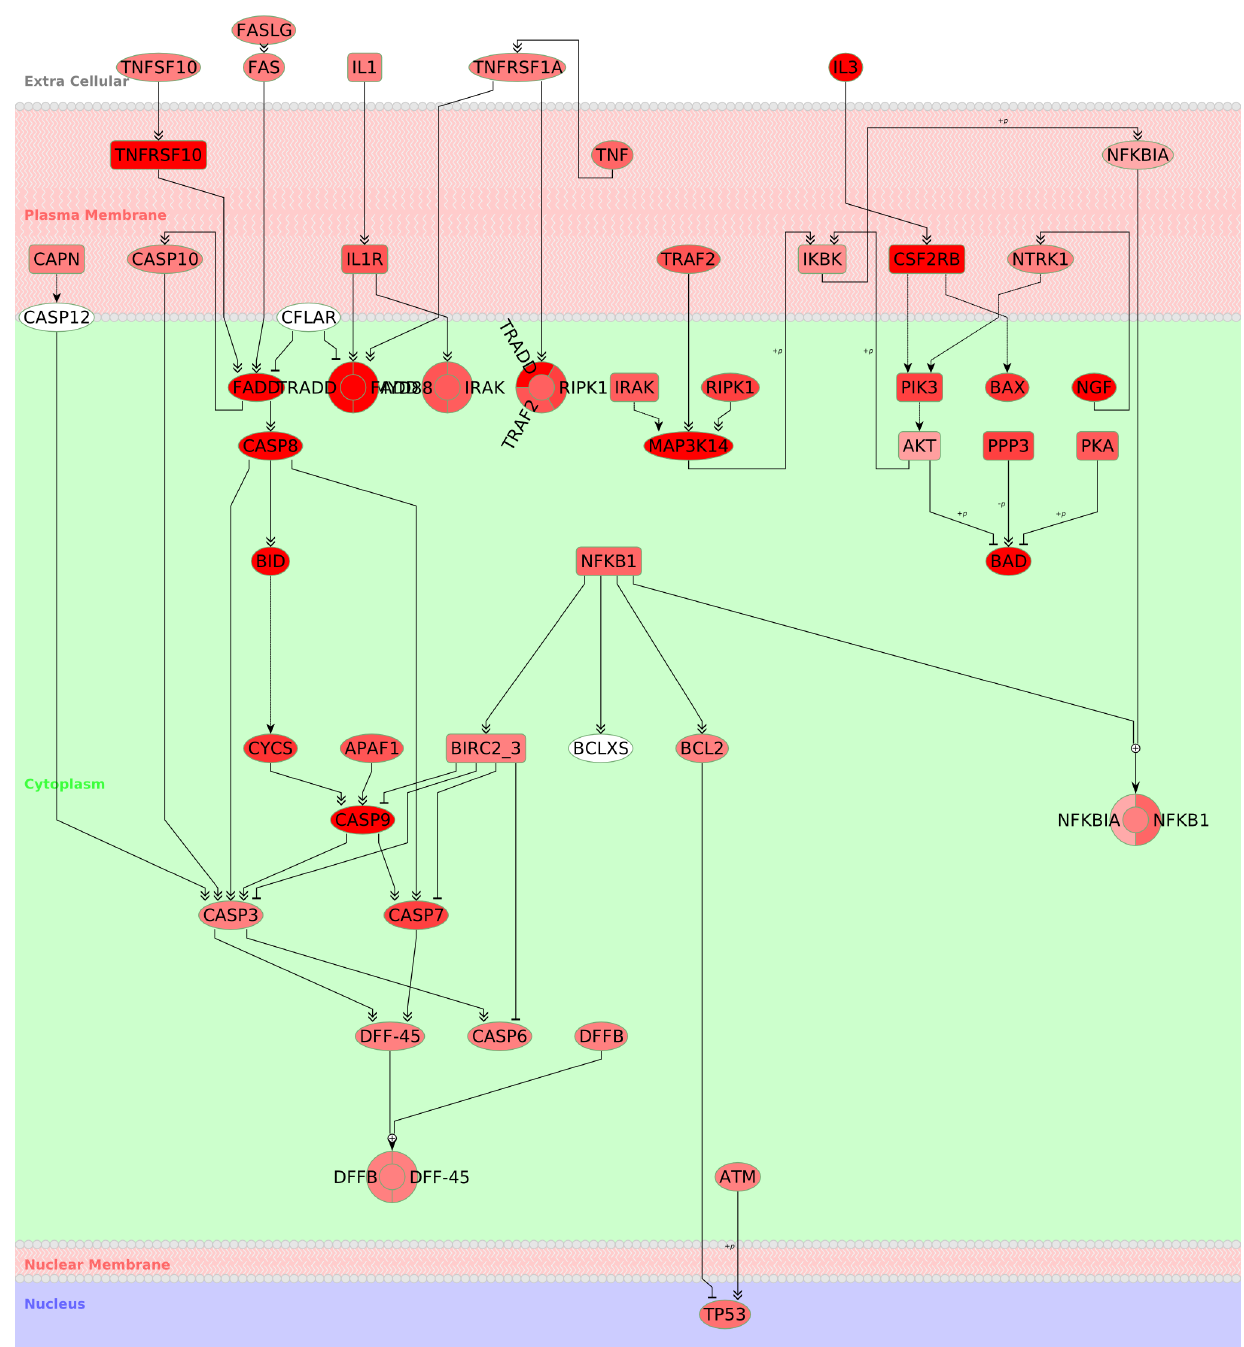
Figure 2. Sub-cellular compartment visualization. The visualization of the KEGG Apoptosis pathway in a layered sub-cellular compartment model demonstrates BiNA possibilities for integrating cellular location information. For this, information, e.g., from SwissProt [29], can be used to assign the proteins to the layout layers, which correspond to an abstract cell model. This representation is meaningful for highlighting signaling cascades into the nucleus. Since, proteins can have multiple cellular locations, it is also possible to validate the compartment assignment by projecting the ambiguity level of the cellular locations to the node colors: From unambiguous (red) via ambiguous (rose) to white (no information available).